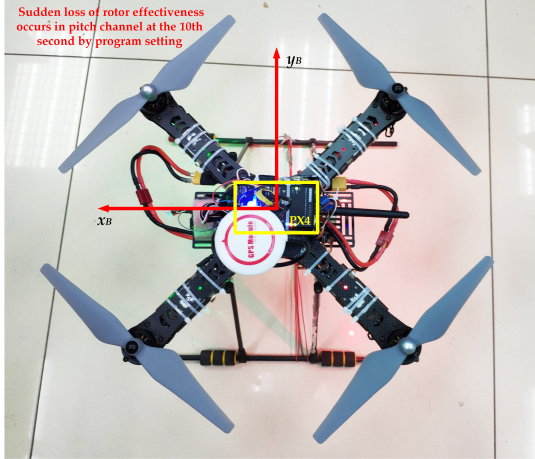
Figure 8. Experimental setup of the quadrotor hovering with sudden lose of rotor effectiveness in Case A.